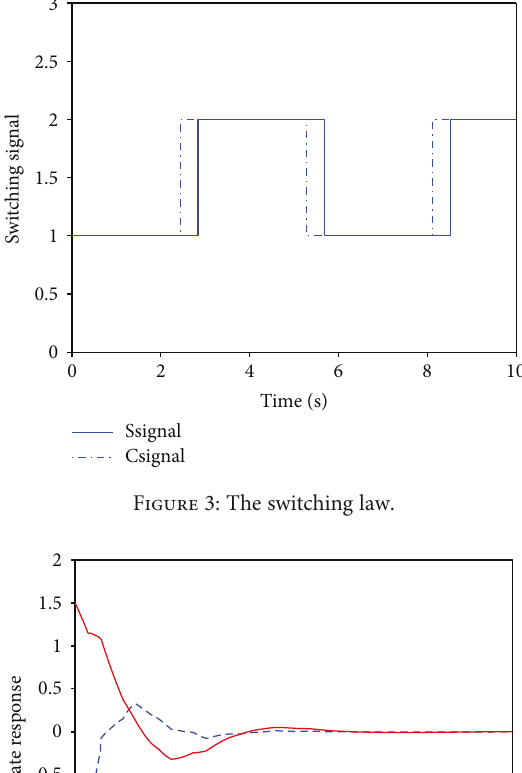
Figure 1: The switching law.